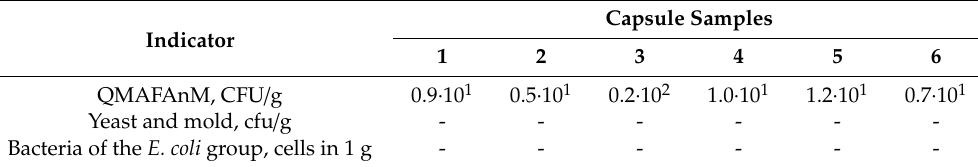
Table 3. The results of the study of microbiological safety indicators of capsules based on plant hydrocolloids.